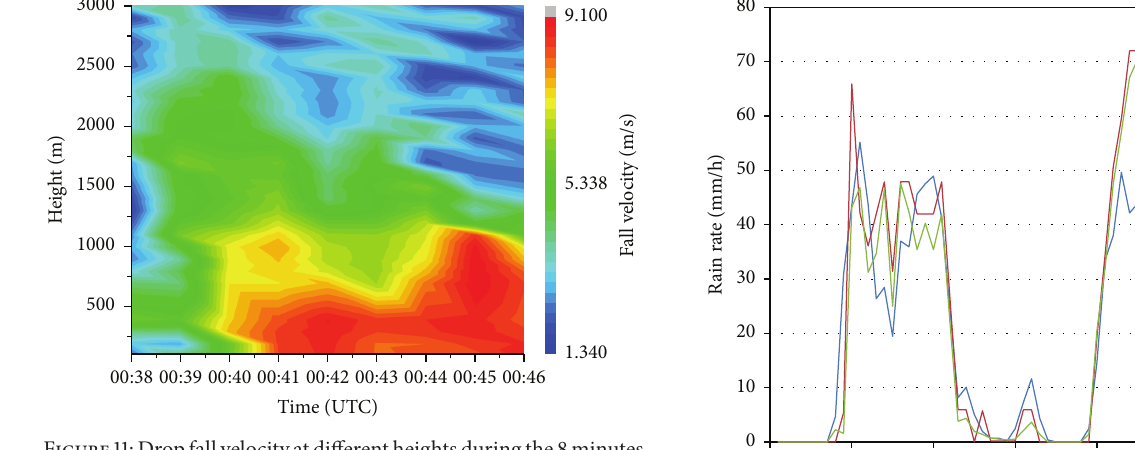
Figure11:Dropfallvelocityatdifferentheightsduringthe8minutes studied.